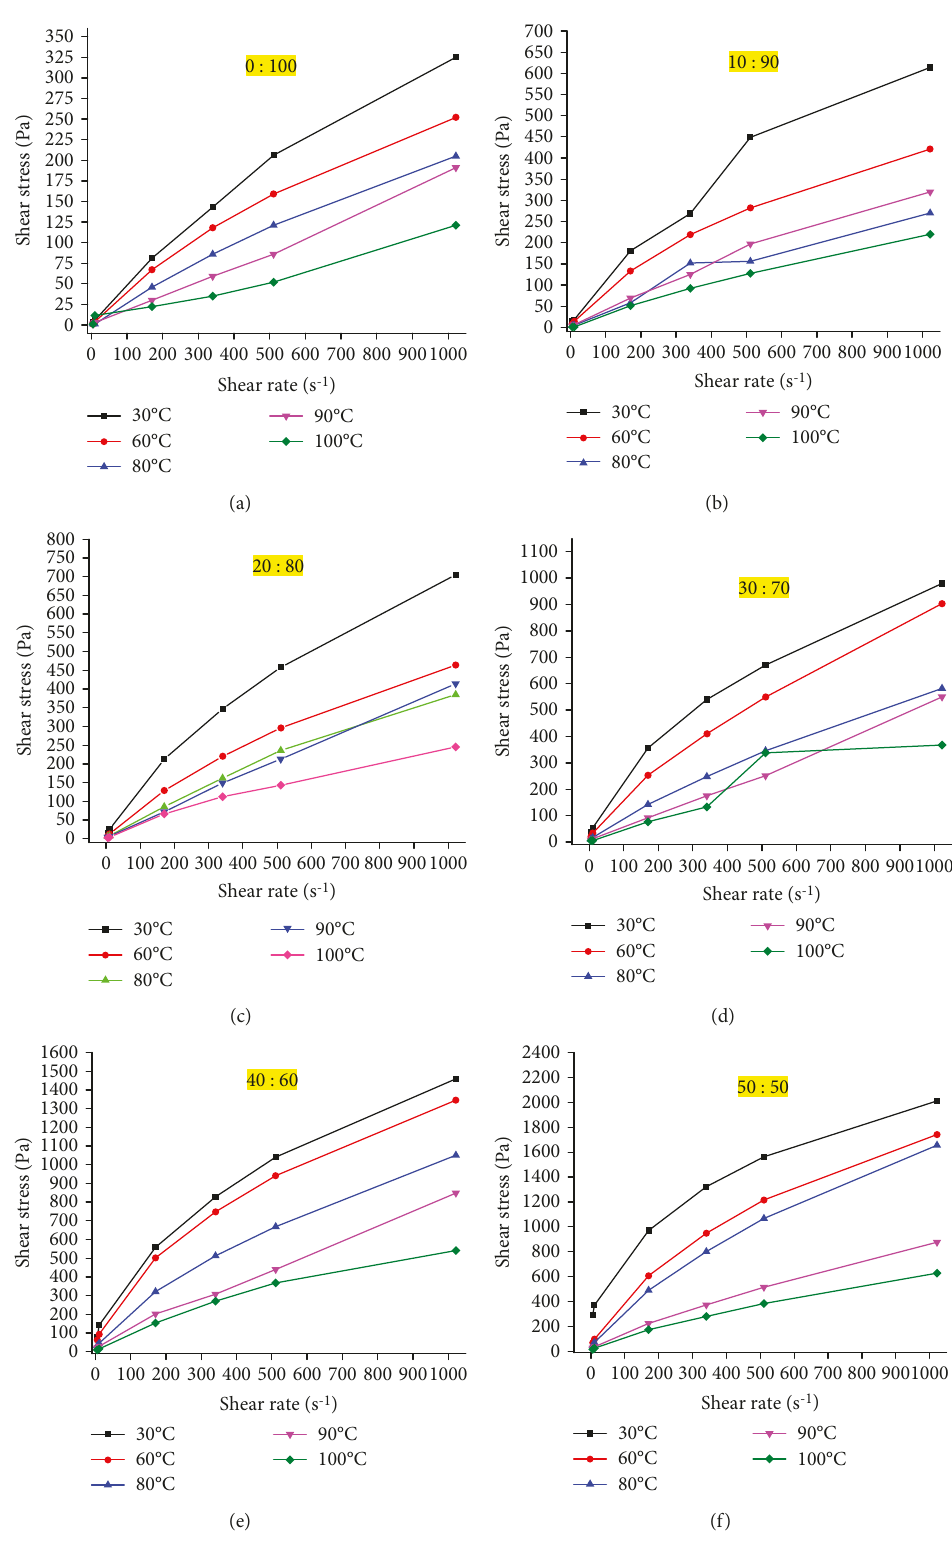
Figure 7: Relationships between the shear stress of di ff erent oil-water ratios of HEC and shear